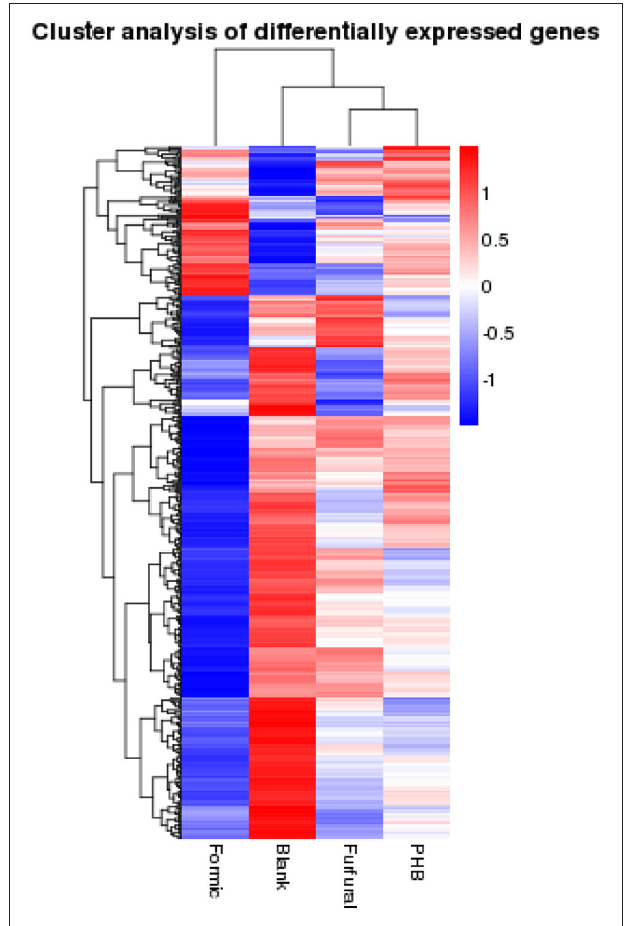
FIGURE 2 | Hierarchical clustering of the differentially expressed genes based on the log 10